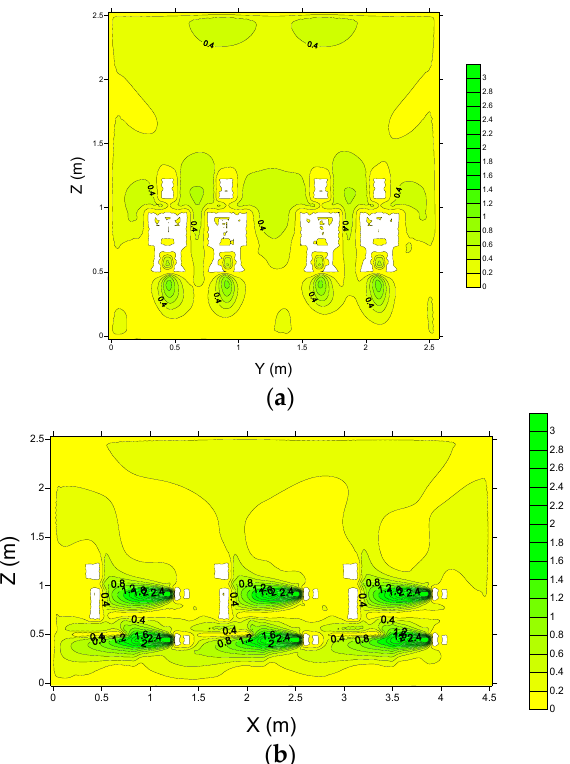
Figure 7. Air velocity field in the virtual classroom with 12 occupants at the plans ( a ) X = 1.791 m and ( b ) Y = 0.4423 m, with an inlet air temperature of 20 °C.